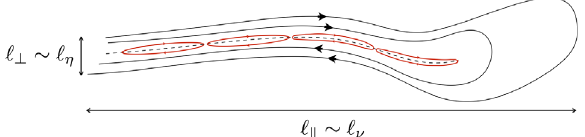
FIG. 1. An illustrative sketch of a characteristic magnetic fold produced during the kinematic stage of the turbulent dynamo, with its length l set by the viscous scale l ν and its width l ⊥ set k by the resistive scale l η . The possibility that such a fold might be disrupted by resistive tearing modes (symbolized by the red islands) in either the kinematic or the nonlinear stage of the dynamo is investigated in this